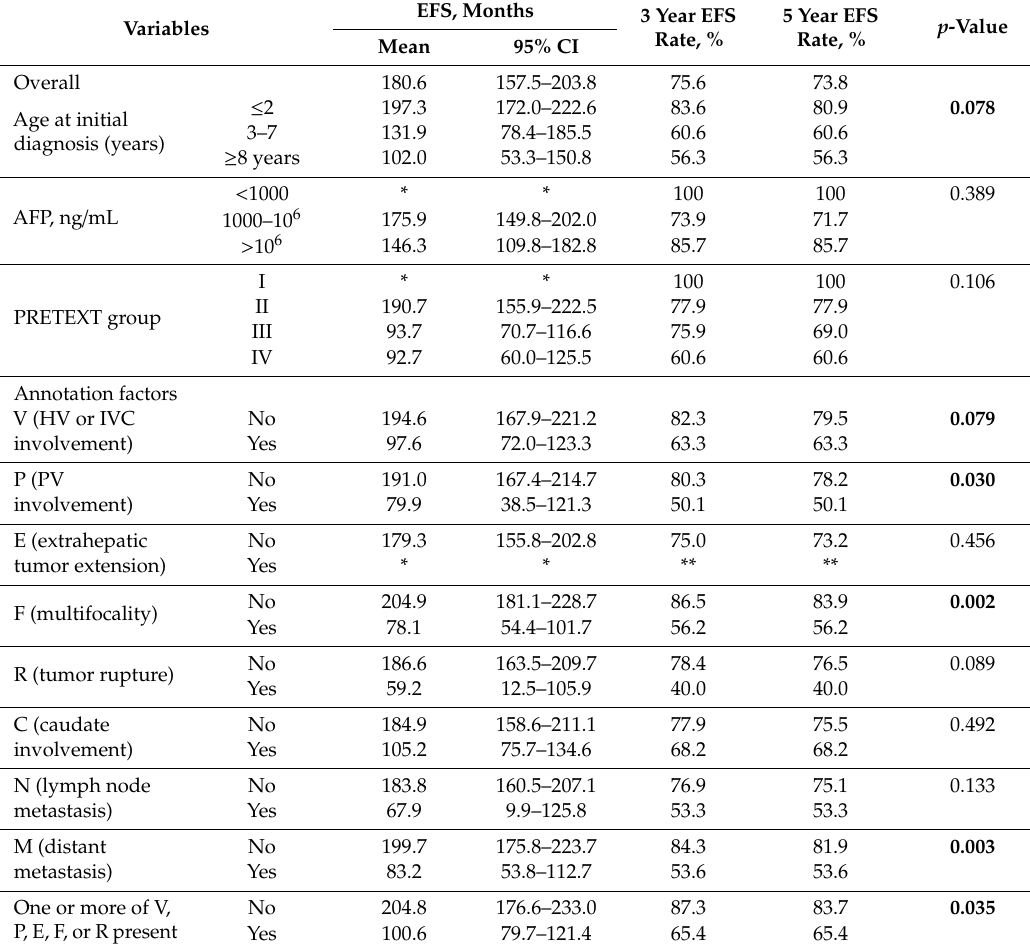
Table 2. The mean event-free survival (EFS) and three- and five-year EFS rates according to each variable used in the 2017 PRE-Treatment EXTent of tumor (PRETEXT) and Children’s Hepatic tumors International Collaboration-Hepatoblastoma (CHIC-HS)